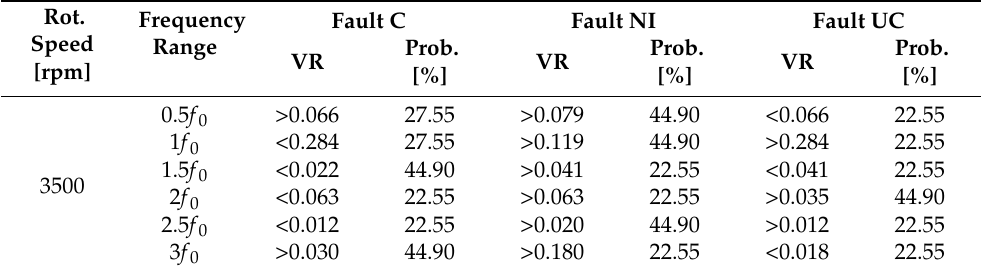
Table 5. Probability ranges for the diagnosis of the defect data for 3500 rpm, where C—efficient engine, NI—injection inefficient, UC—pressure inefficient, and VR—value range.